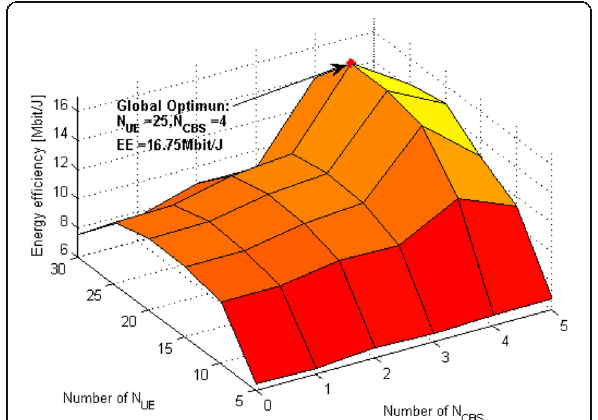
Fig. 6 EE with different coordination schemes, N UE ∈ {10, 15, ⋯ , 30}, R = 2bit/s/Hz, and N BS = 64